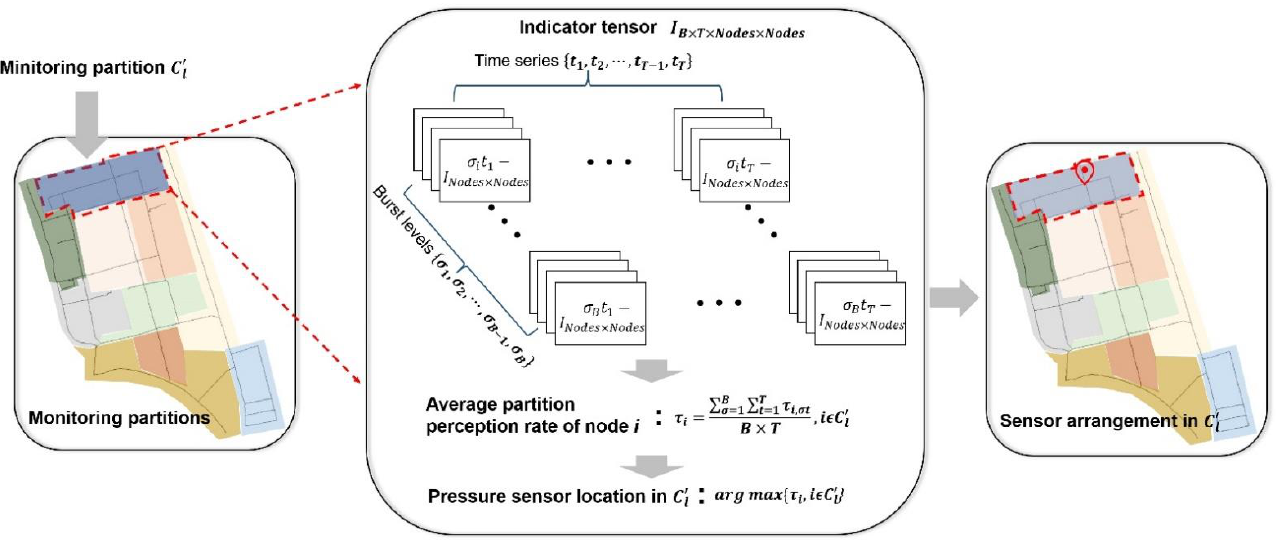
Figure 3. Arrangement of monitoring